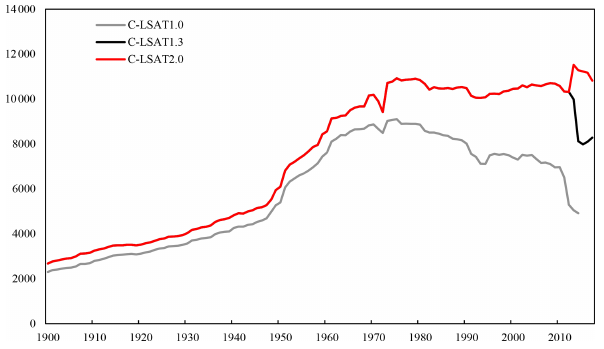
Figure 1. Comparison of C-LSAT 1.3 and C-LSAT 2.0 site counts from 1900 to